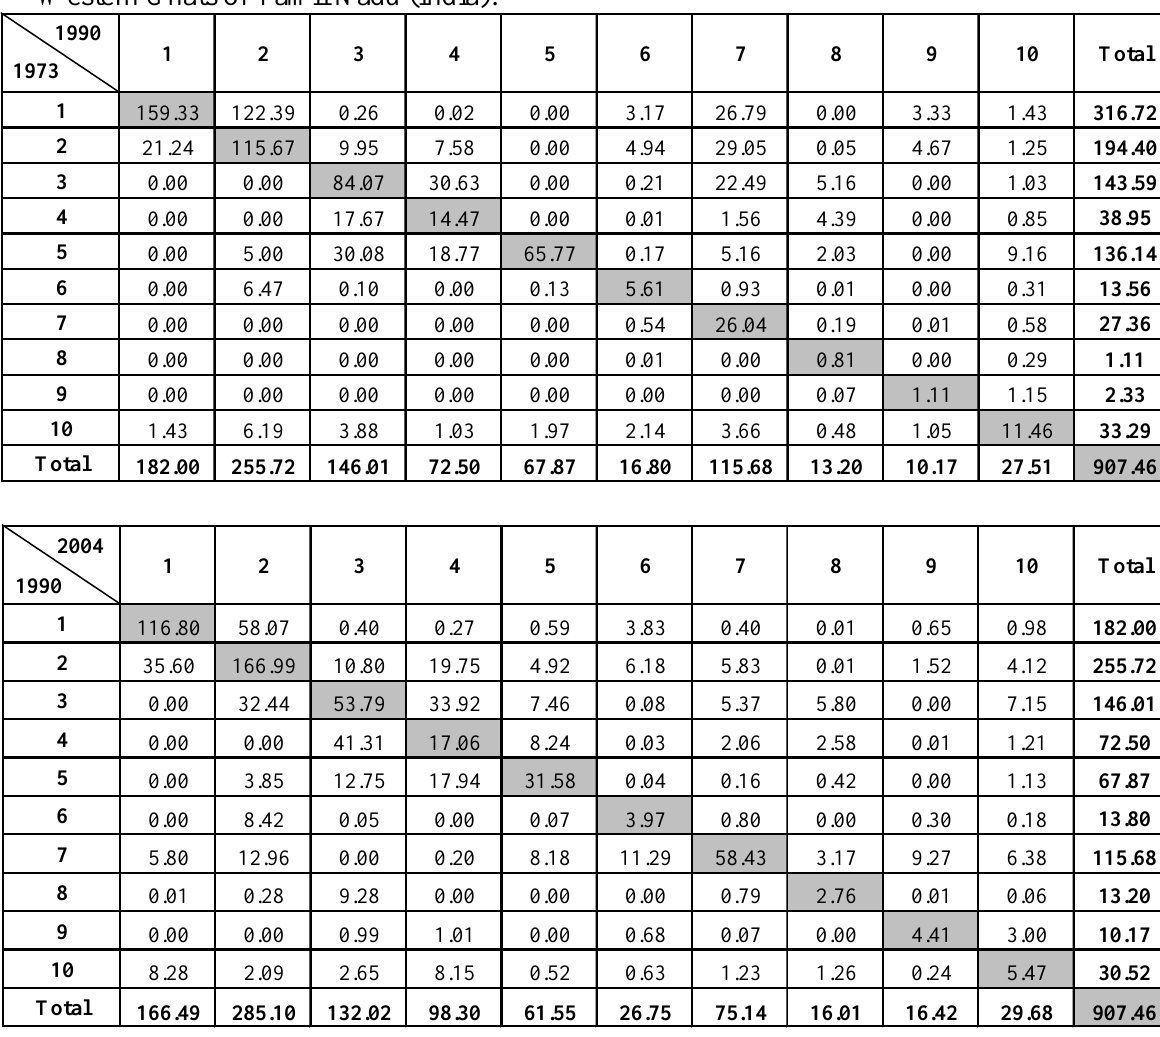
Table 2. Change matrix for the KMTR between 1973 to 1990 and 1990 to 2004, South Western Ghats of Tamil Nadu